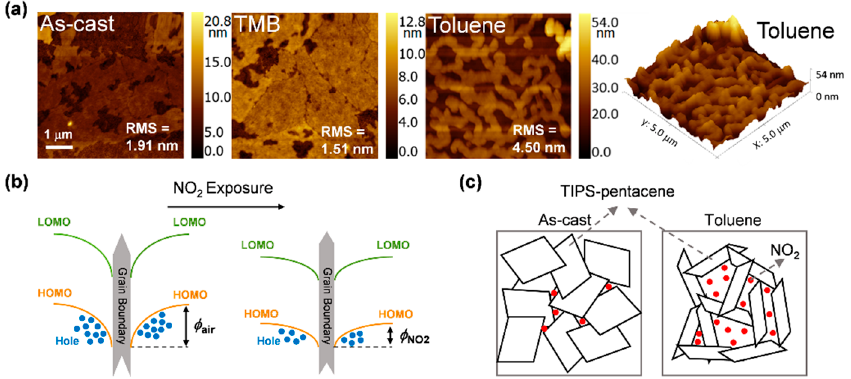
Figure 3. ( a ) AFM height images of the OTFTs. ( b ) Band diagram of the grain boundary before and after NO 2 exposure. ( c ) Schematic of the two kinds of TIPS-pentacene films under NO 2 . Real-time responsivities of the sensors were next measured under various NO 2 con- centrations (0.2, 0.5, 1, 2, 5 and 10 ppm) to further analyze the sensing performance. As shown in Figure 4a, the response of the toluene treated-device increases distinctly at all the NO 2 concentrations. For instance, upon to 10 ppm NO 2 , the responsivity of the toluene- treated device showed 13 × greater performance (566%) than the pristine device (44%). The response of the toluene-treated device to low concentration NO 2 (200 ppb) was still as high as 167%, while that of the pristine device is 13%. Owing to the limitation of gas sources and the flow control system, 0.2 ppm was the lowest NO 2 concentration that could be reliably used in these tests. Nevertheless, the LOD could be estimated by the root mean square deviation (RMSD) method [33]. As shown in Figure 4b, the responsivities of the toluene treated device to 0.5, 1, and 2 ppm NO 2 were 185, 257, and 364%, respectively, which